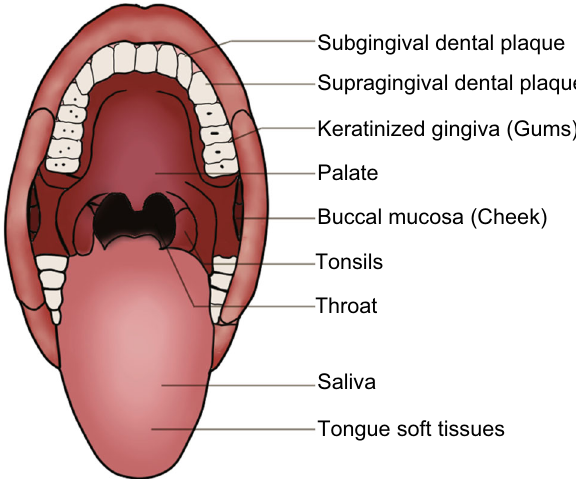
Figure. 1. Nine specimens were collected in the HMP population. Saliva, buccal mucosa (cheek), keratinized gingiva (gums), palate, tonsils, throat and tongue soft tissues, and supra gingival and subgingival dental plaque (tooth bio fi lm above and below the